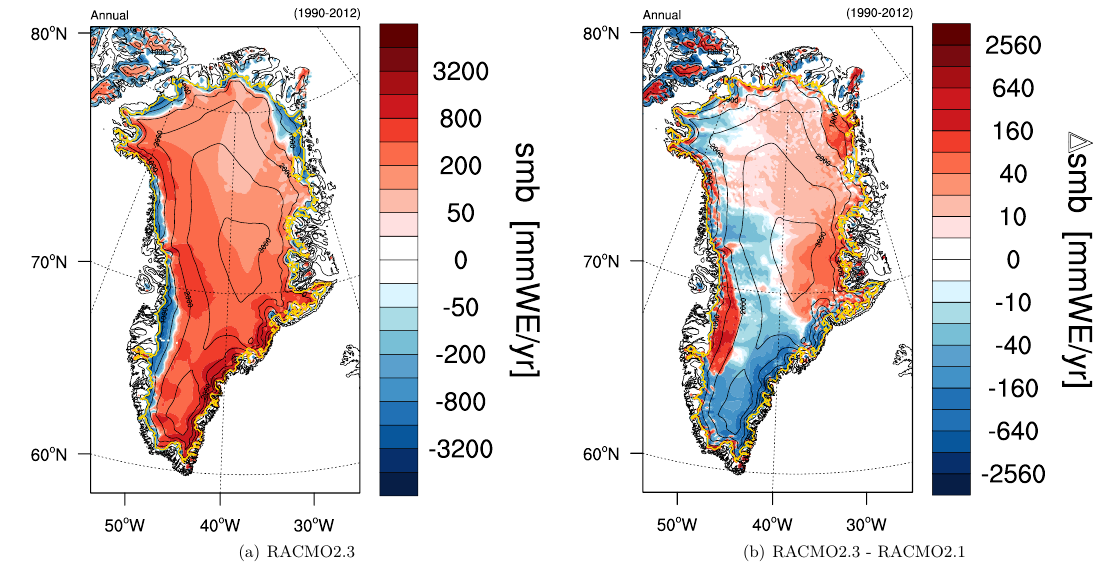
Figure 2. (a) Mean annual SMB (mmWEyr − 1 ) in RACMO2.3; (b) change in mean annual SMB (mmWEyr − 1 ) between RACMO2.3 and RACMO2.1 (1990–2012). The ice sheet margin is displayed in